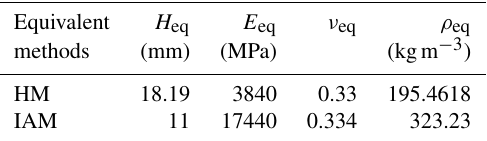
Table 9. Equivalent material parameters of the Hoff (1948) theory (HM) and the improved Allen (1969) equivalent method (IAM).